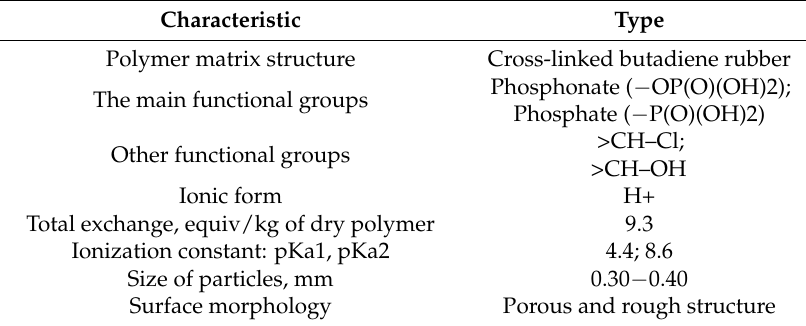
Table 1. The main characteristic of the PhCP.